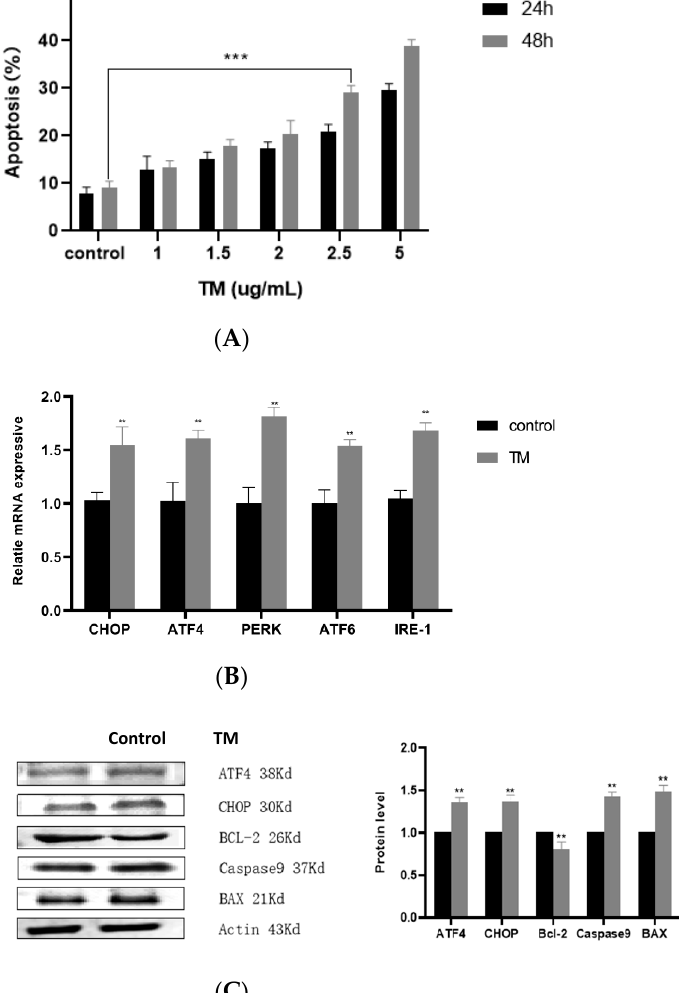
Figure 2. Construction of an ER stress model: ( A ) Cells were treated with TM at the indicated dose of 0 － 5 μ g/mL for 24 h and 48 h. Ten thousand cells were treated with Annexin V-FITC and PI reagent and analyzed on a fluorescence-activated cell sorting (FACS) instrument. Percentages of Annexin V-positive/PI-negative and Annexin V-positive/PI-positive cells are shown. ( B ) q-PCR analysis of Perk , Ire1 , Atf6 , Chop , and Atf4 mRNA expression in GCs after TM treatment. ( C ) Western blotting was performed to detect the protein level with the indicated antibodies against ATF4, CHOP, BCL-2, Caspase9, and BAX. The asterisks refer to the level of significance (** p < 0.01, ** * p < 0.001). Values are presented as means ± SD for 3 biological replicates.